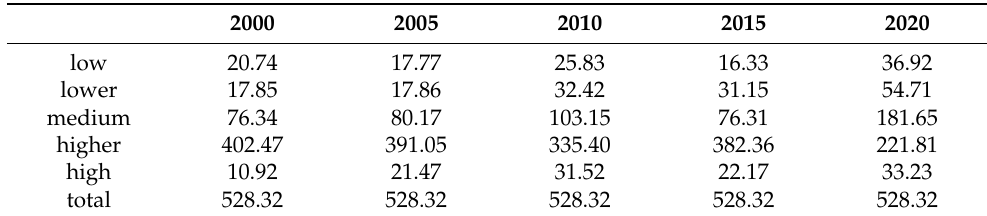
Table 3. NDVI area statistics of each year (Unit: km 2 ).